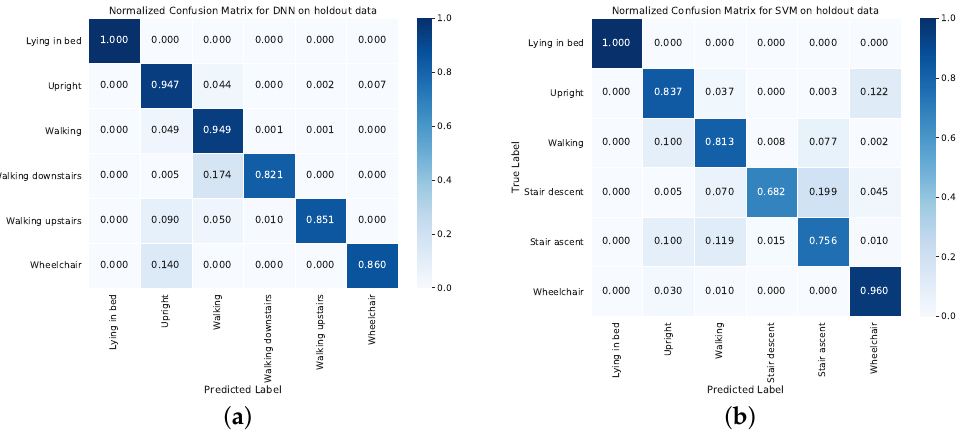
Figure 4. Normalized confusion matrices on holdout data of ( a ) the deep neural network (DNN) and ( b ) the support vector machine (SVM) classifier.